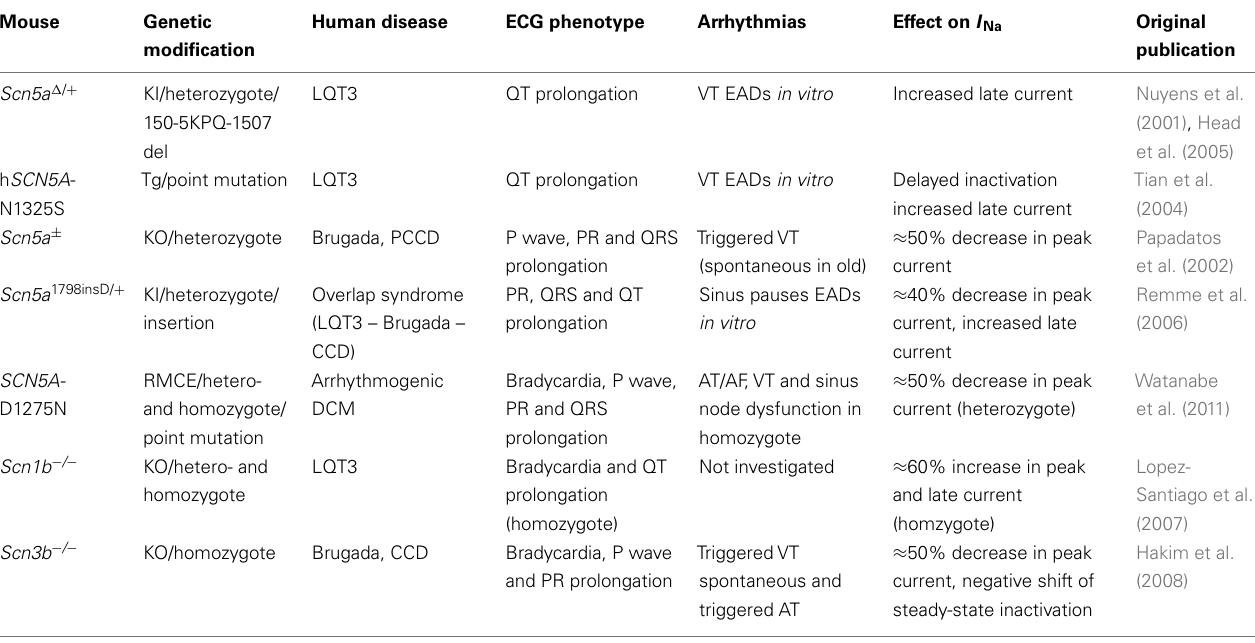
Table 1 | Mouse models of SCN5A -related cardiac genetic